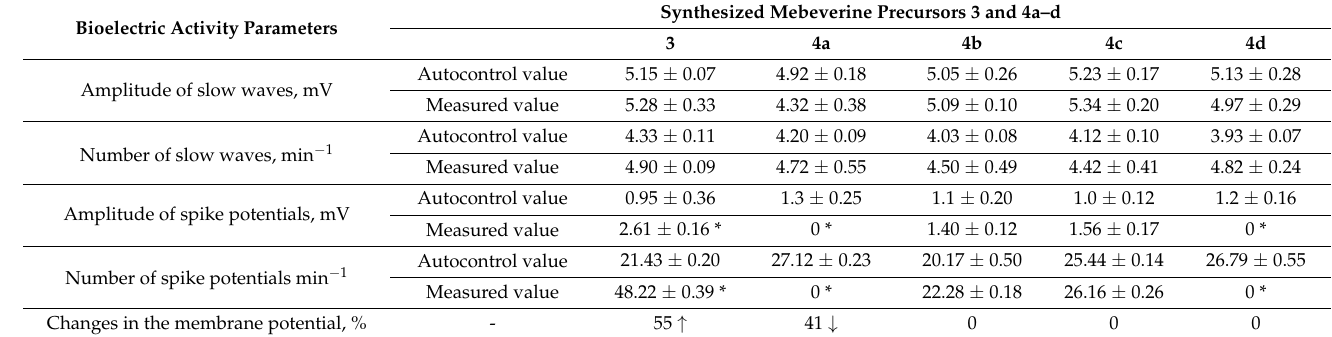
Table 5. Changes of some bioelectric parameters of SM preparations registered through sucrose